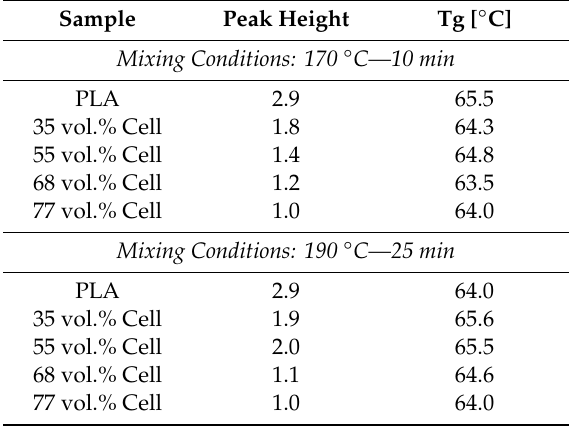
Table 5. Temperature in correspondence to the maximum of the tan delta curves for the PLA